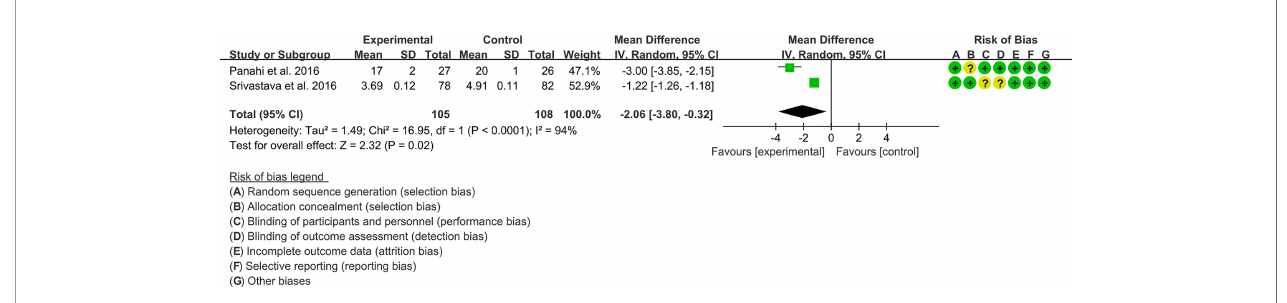
FIGURE 12 | The results of MDA.